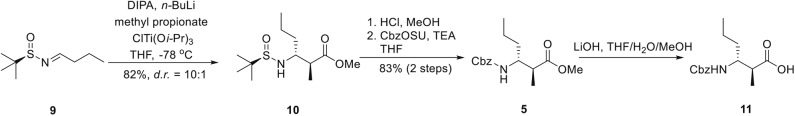
Synthesis of β-amino acid 11.